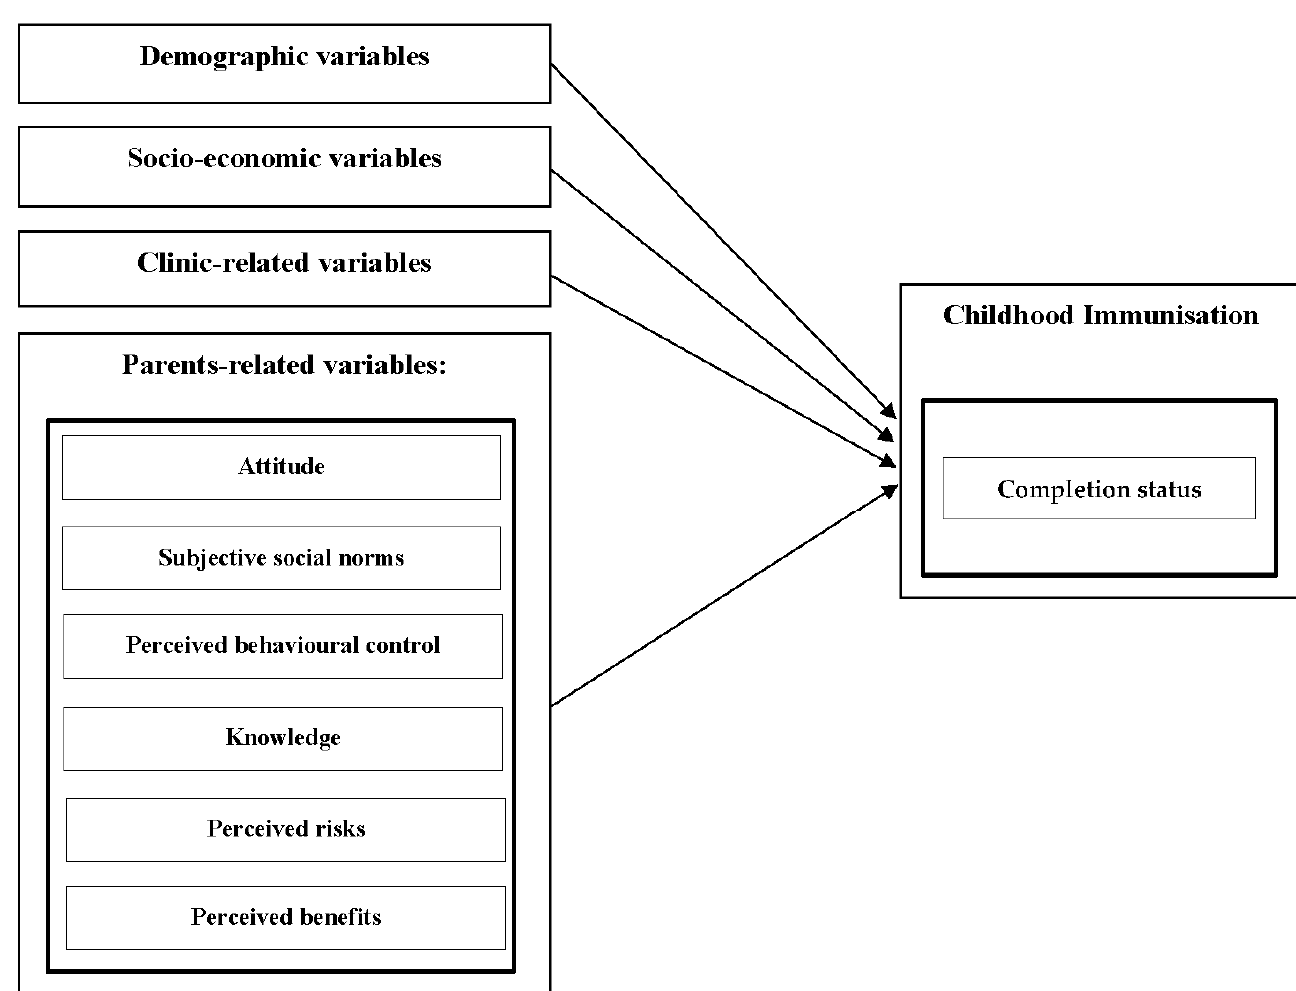
Figure 3. Framework for the study.